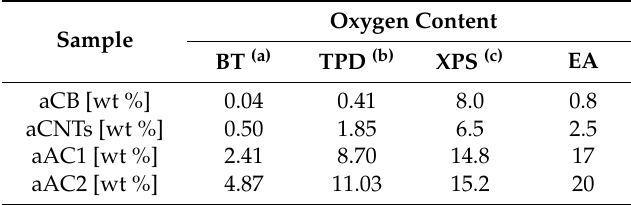
Table 4. Total oxygen content in the carbon samples determined by the different analytic